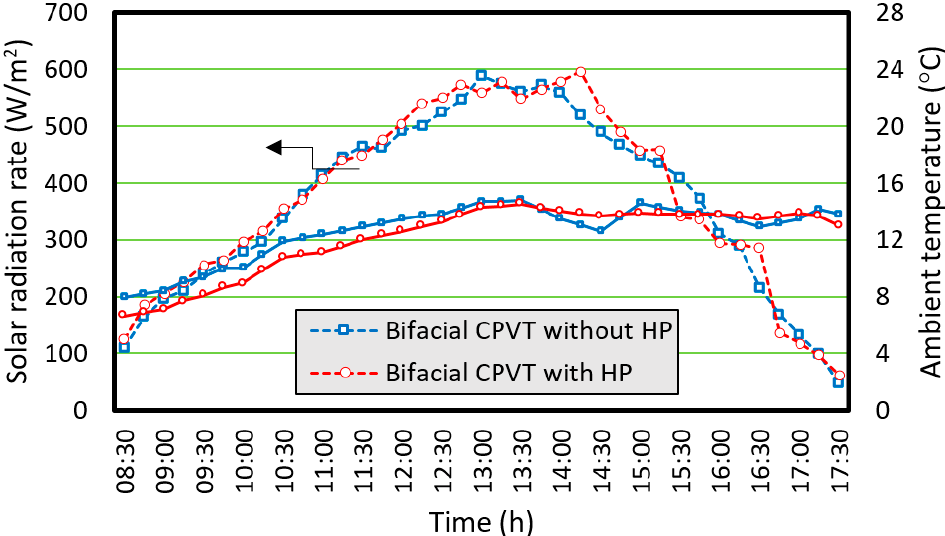
Figure 4. Changes in the environmental conditions in the bifacial CPVT systems with and without HP. The black arrows show the solar radiation rate values of the two dashed lines.